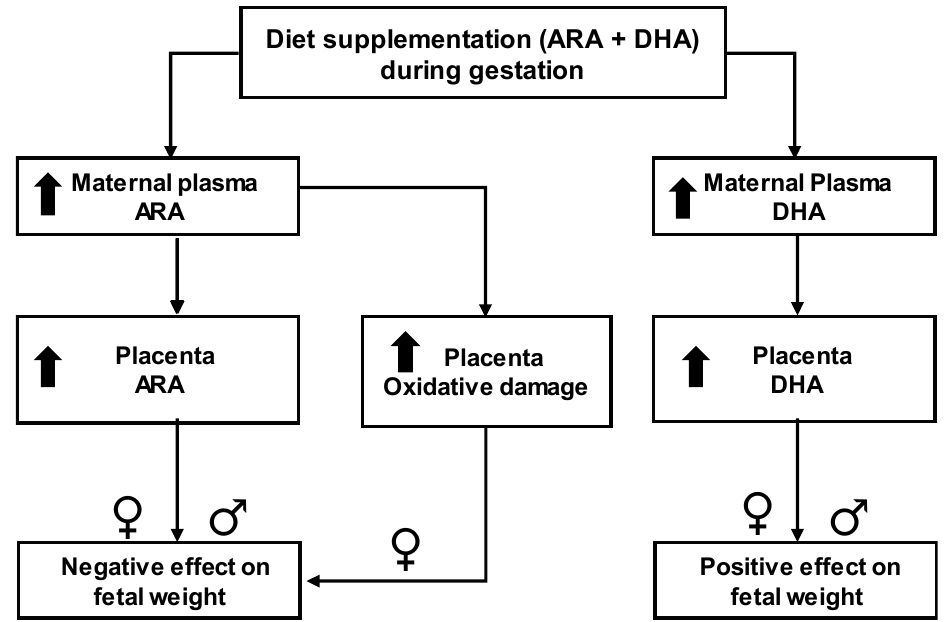
Figure 8. Schematic diagram showing main findings. ARA, arachidonic acid; DHA, docosahexaenoic acid; up-arrows indicate an elevation in response to the dietary intervention.